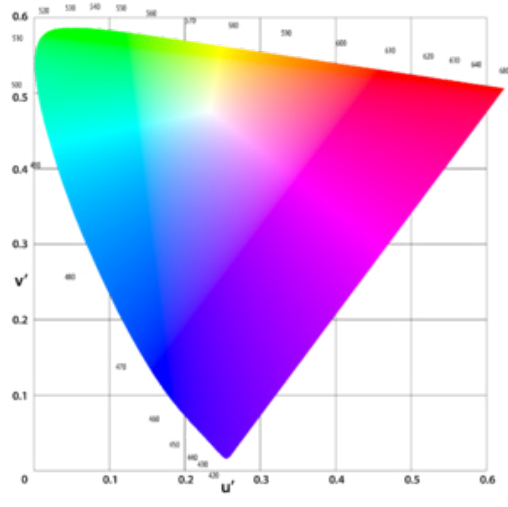
Figure 2: The CIE 1976 chromaticity diagram, shows a more appropriate allocation of area to each colour, as discussed in the text.